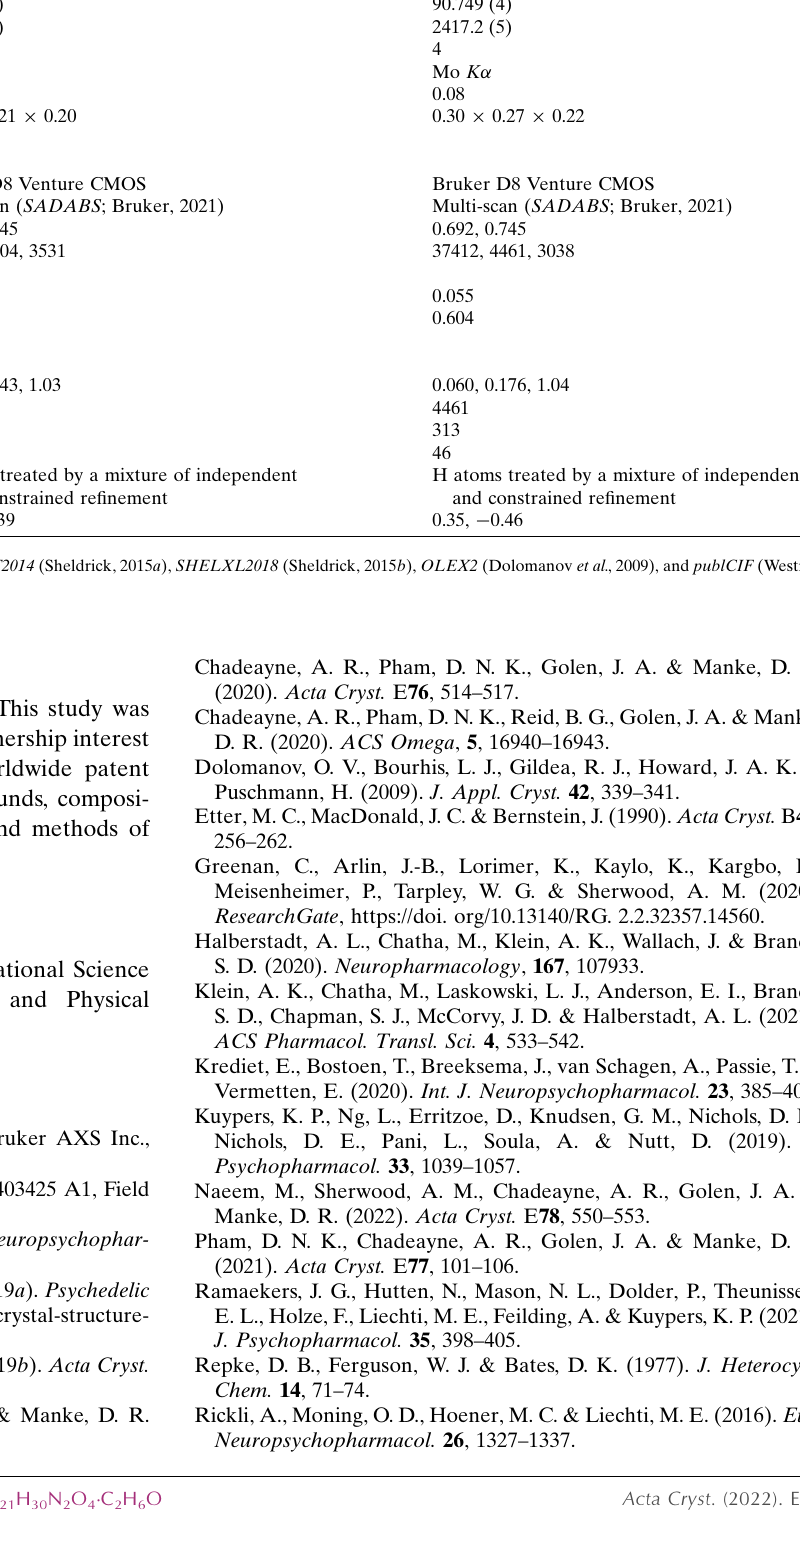
Table 3 Experimental details. Crystal data Chemical